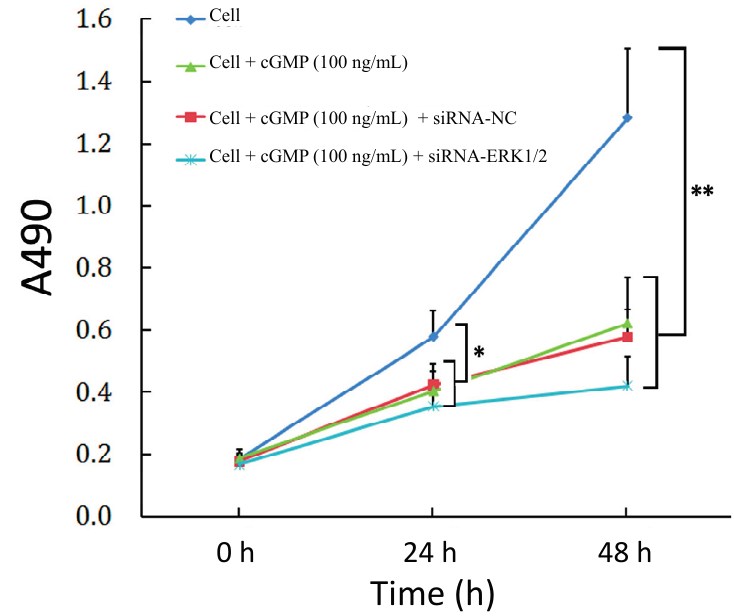
Figure 4. Effects of ERK block on cellular proliferation. Cells were incubated with 100 ng/mL cGMP or siRNA targeting ERK and MTT assay was performed 24 or 48 h later. The result showed that cGMP and ERK silencing both reduced the proliferative activity of microartery endothelial cells, with a significant difference at 24 and 48 h ( p < 0.05 or 0.01, vs. control group), through there was no significant difference between these two groups. * p < 0.05 and ** p < 0.01, vs. control group. Cell Cell + cGMP (100